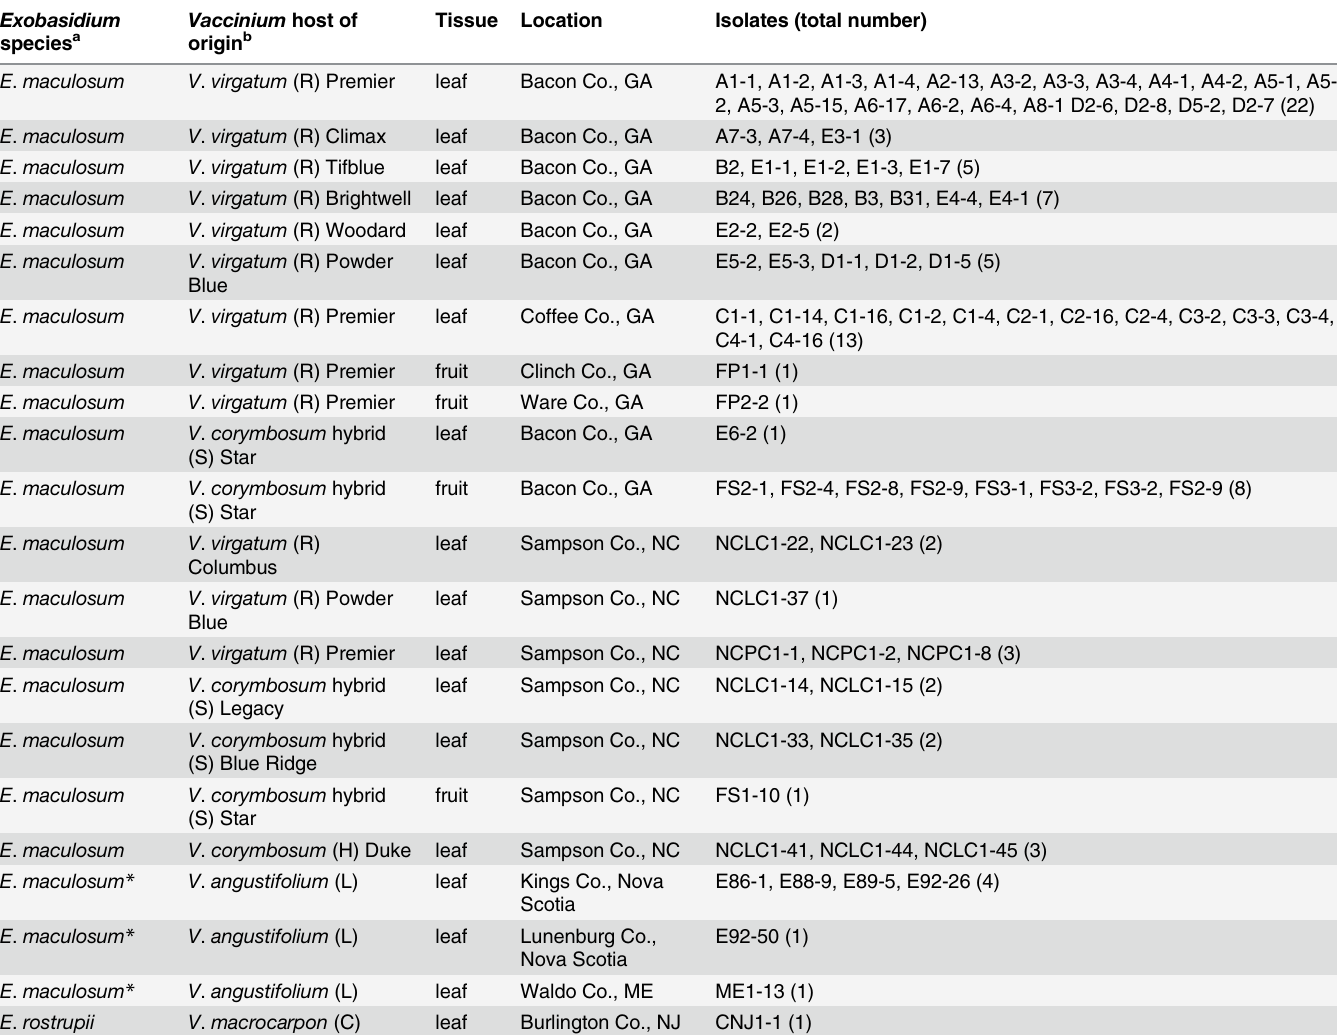
Table 1. Original Vaccinium host, tissue type, and geographic location for Exobasidium maculosum and E . rostrupii isolates.